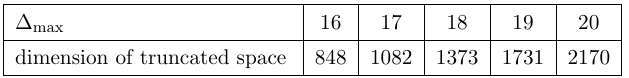
Table 11. Dimensions of truncated spaces in the tricritical Ising model with (d)